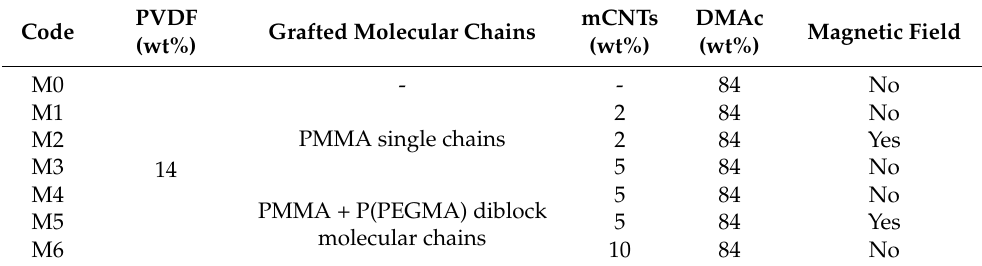
Table 1. PVDF composite membrane notation and its composition of dope solutions with or without magnetic field